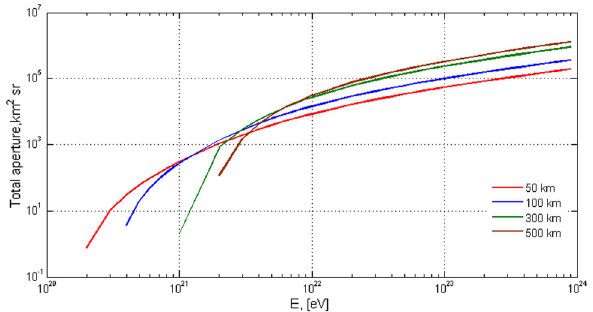
Fig. 7 Total aperture of the UHE neutrinos for a lunar orbital ULW radio antenna at different altitudes of 50, 100, 300, and 500km with sensitivity of 1.34